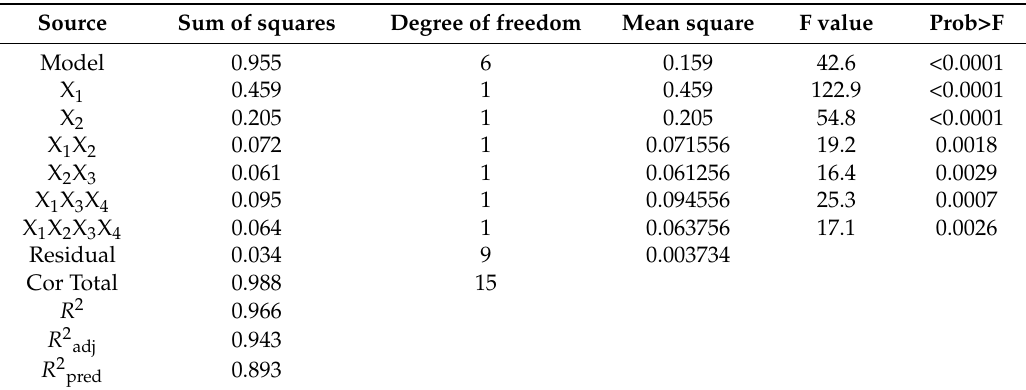
Table 4. Statistical result of ANOVA for reduced model of the response variable “purification factor